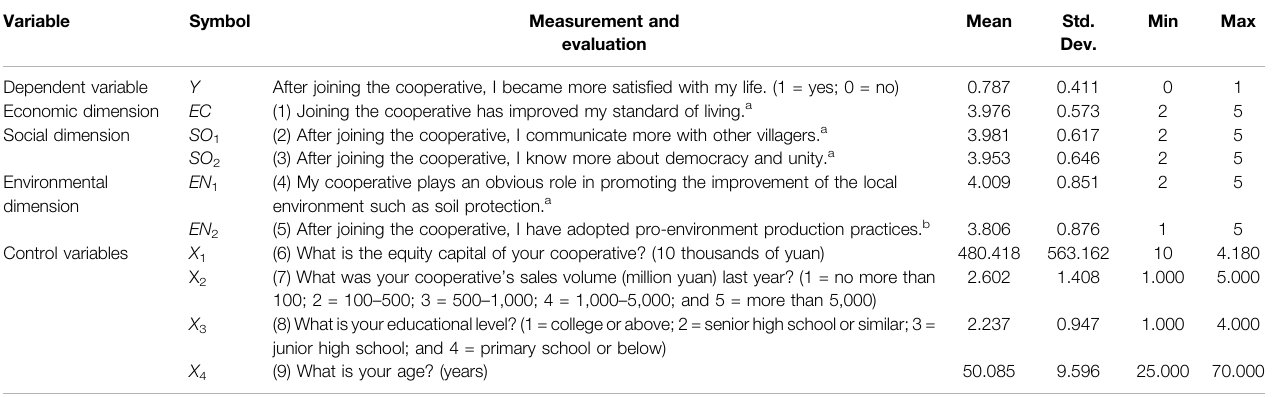
TABLE 1 | Dependent and independent variables and descriptive statistics for the models. Variable Symbol Measurement and